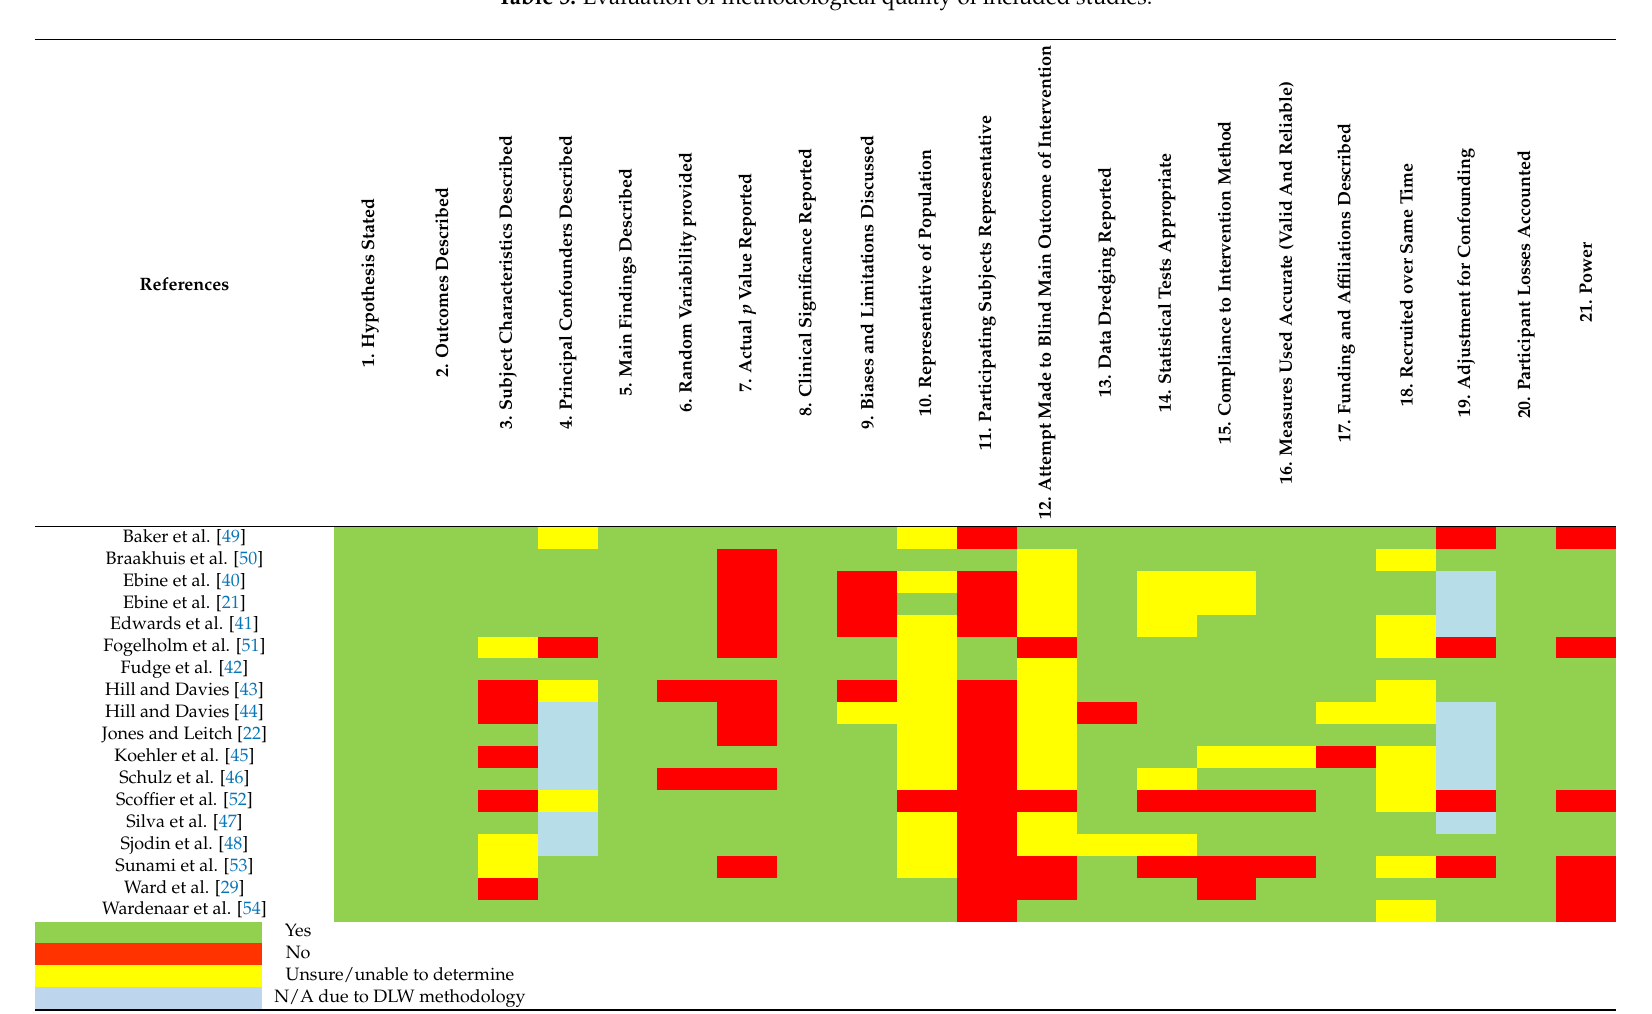
Table 5. Evaluation of methodological quality of included